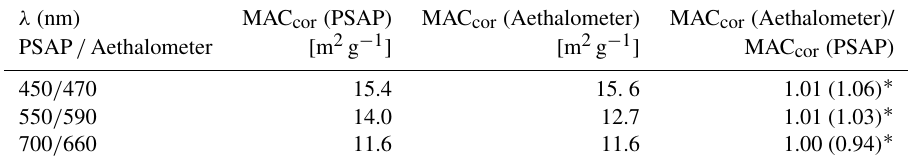
Table 5. MAC cor (PSAP) and MAC cor (Aethalometer) values derived from 24h averaged data at Alert during 2018–2019.